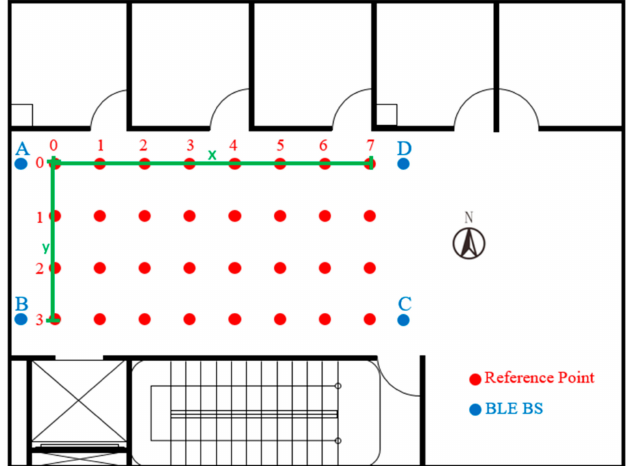
Figure 7. Schematic Diagram of Planned Reference Points in the Environment.